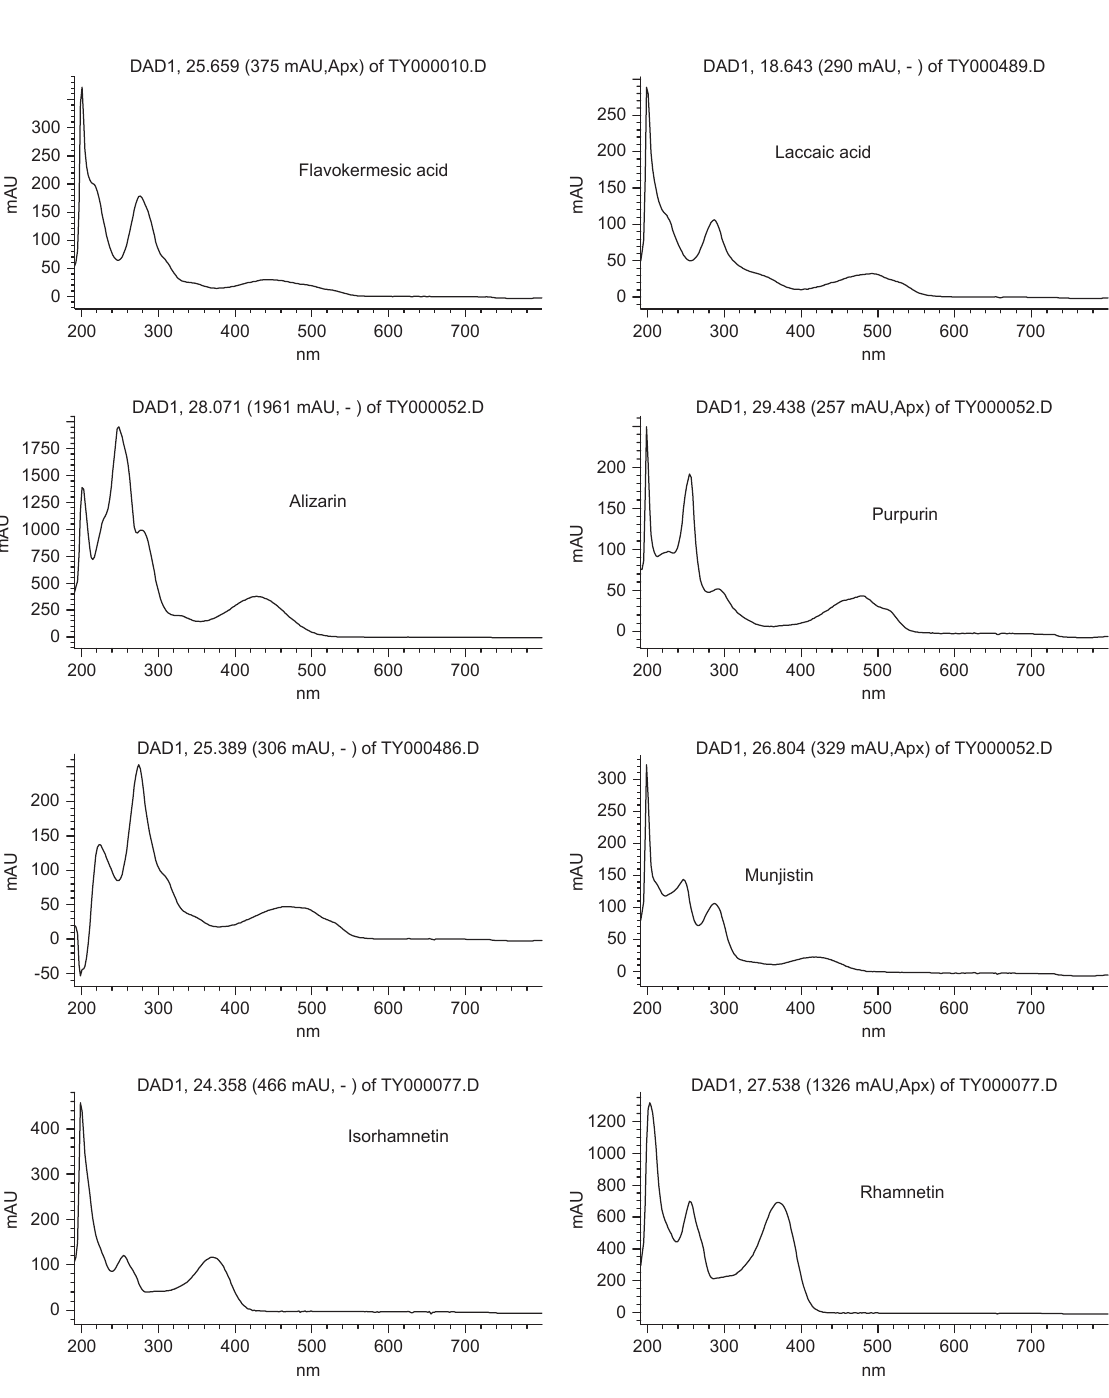
Figure 4 UV-visible absorption spectra of newly dyed samples as reference standards. gradient elution programme that utilises two solvents: A: O – 0.1 % TFA and B: CH CN – 0.1 % TFA at a fl ow rate H 2 3